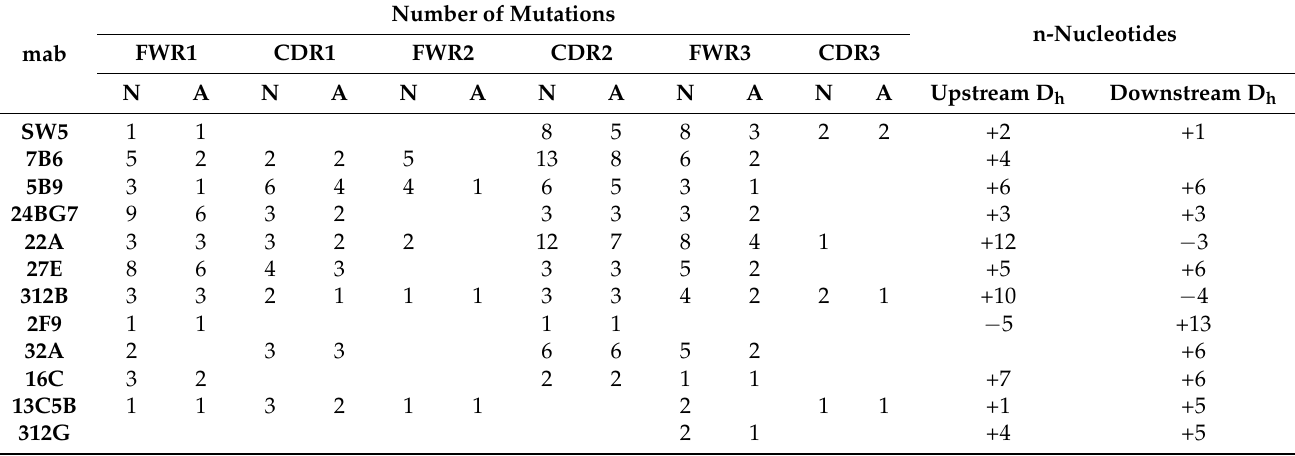
Table 3. Analysis of mutation rate calculated for the respective heavy chain. The sequences of the V h domains listed in Table 1. were compared and the number of mutations calculated which occurred at the nucleotide (N) or aa level (A). Additional or missing nucleotides upstream or downstream of the D h element are also given (n-nucleotides). The primer dependent first 23 nucleotides were not included in the